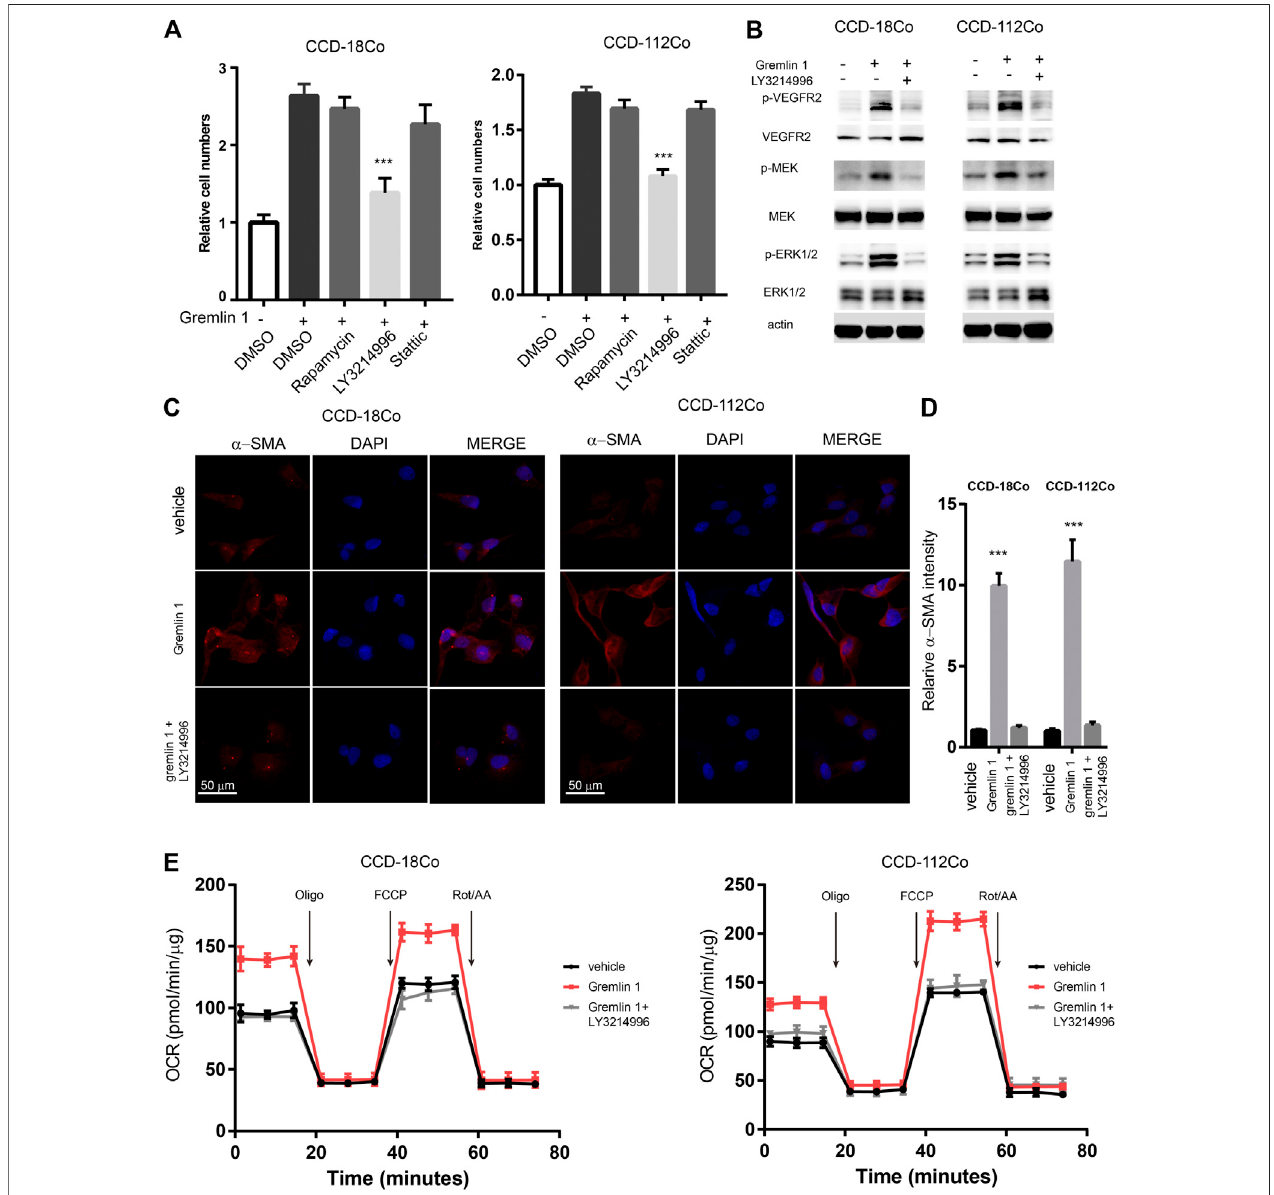
FIGURE 5| VEGFR2-MEK-ERK axis mediated the enhancement ofFAO from Gremlin 1. (A) . Cell viability assay of human intestinal fi broblast cells CCD-18Co and CCD-112Co cells treated with 200 ng/ml Gremlin 1 and Rapamycin (10 nM), LY3214996 (10 nM) or stattic (10 μ M) for 24 h. (B) . Immunoblotting analysis of VEGFR2- MEK-ERKsignalinginhumanintestinal fi broblastcellsCCD-18CoandCCD-112Cocellstreatedwith200 ng/mlGremlin1andLY3214996(10 nM)for24 h.Actinacted asloadingcontrolandre-usedforillustrativepurposes. (C) .Immuno fl uorescencestainingofa-SMAinhumanintestinal fi broblastcellsCCD-18CoandCCD-112Co cells treated with 200 ng/ml Gremlin 1 and LY3214996 (10 nM). (D) . The intensity statistical results of a-SMA immuno fl uorescence staining from fi ve random fi elds of slides.E.OCRmeasurementofCCD-18CoandCCD-112Cocellstreatedwith200 ng/mlGremlin1andLY3214996(10 nM)for24 h. p valuesarederivedfromone-way ANOVA analysis. Dunnett ’ s test was used to analysis the difference between control group to the other groups. ** p ≤ 0.01; *** p ≤